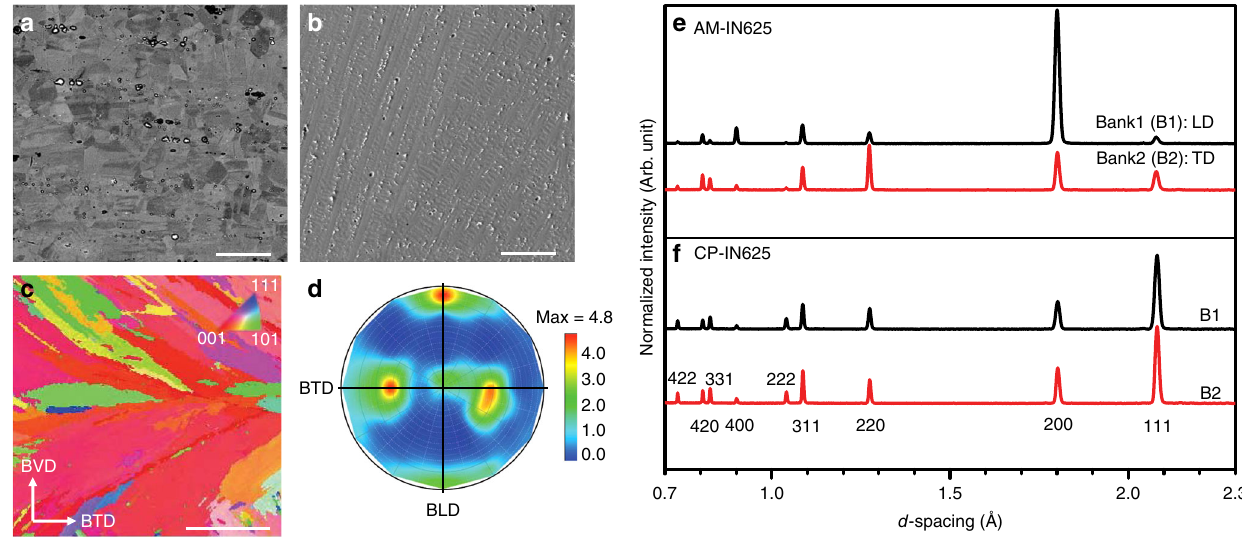
Fig. 3 Microstructure and texture in conventionally processed and additively manufactured Inconel 625. a Backscattered electron image of etched CP- IN625 with Mo- and Nb-rich (bright) and Ti-rich (dark) carbides. Scale bar: 50 μ m. b Secondary electron image of etched AM-IN625 with Mo- and Nb-rich carbides, N-rich phase, and Laves phase. Scale bar: 50 μ m. c EBSD map of planes whose normal is parallel to the build length direction (BLD). Here BTD denotes the build thickness direction, and BVD denotes the build vertical direction. The colors correspond to the hkl plane normals coming out of the page. Scale bar: 500 μ m. d (200) pole fi gure of the AM build determined from neutron diffraction, showing a Goss texture component: {011} <001>. The center of the pole fi gure is parallel to the BVD. e , f Neutron diffraction patterns, in the loading direction (LD) and transverse direction (TD), of AM-IN625 and CP- IN625 samples at 600 °C prior to